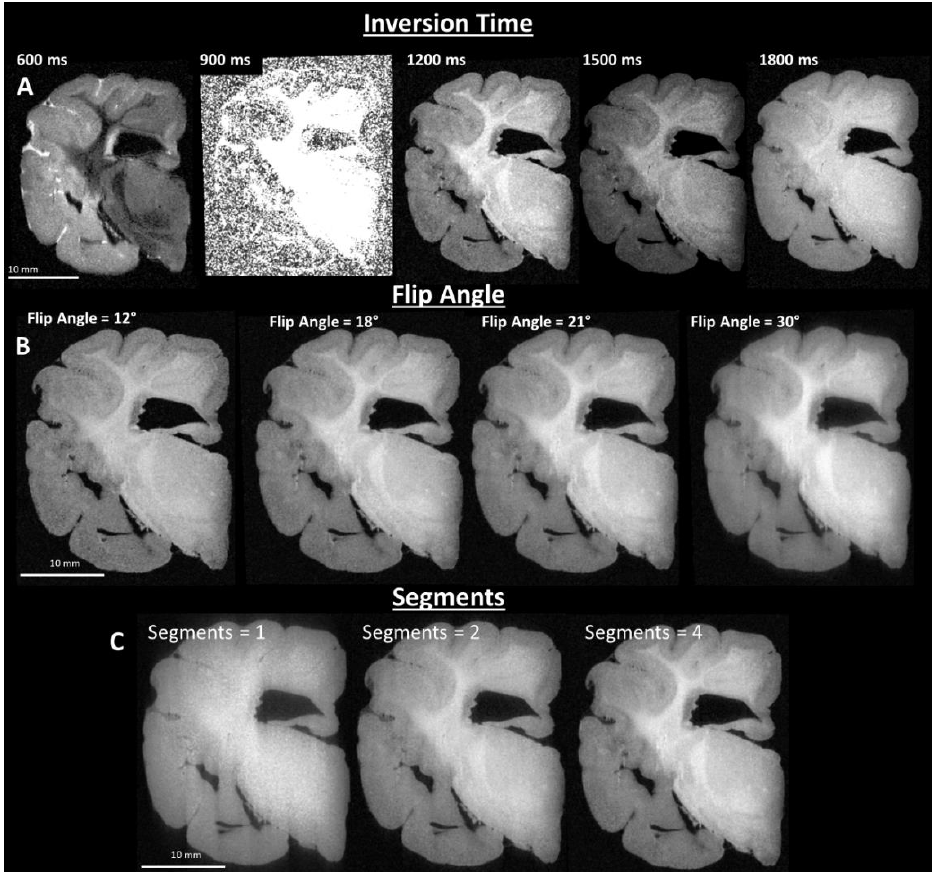
Figure 2. Imaging parameter optimization of T1-weighted images. A ) Inversion time